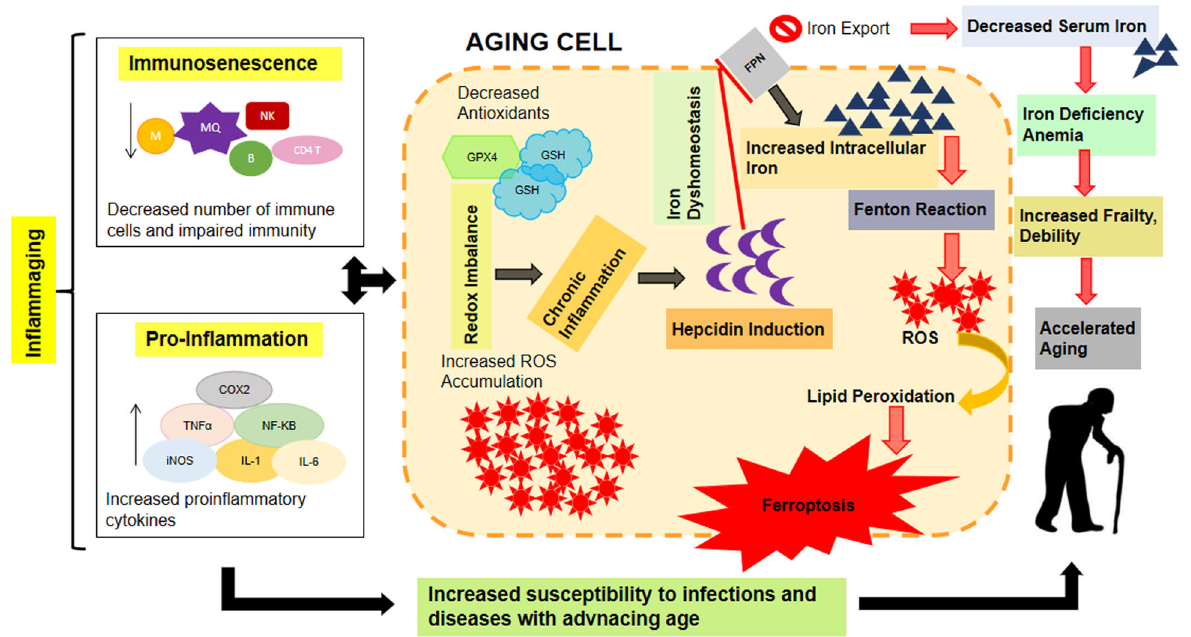
Fig. 2 Proposed mechanism of interaction between iron dyshomeostasis, ferroptosis, and hepcidin in aging. Age related decline of immunity and redox imbalances leads to chronic in fl ammation and induction of hepcidin resulting in iron dyshomeostasis and ferroptosis that contributes to accelerated aging and age related frailty and